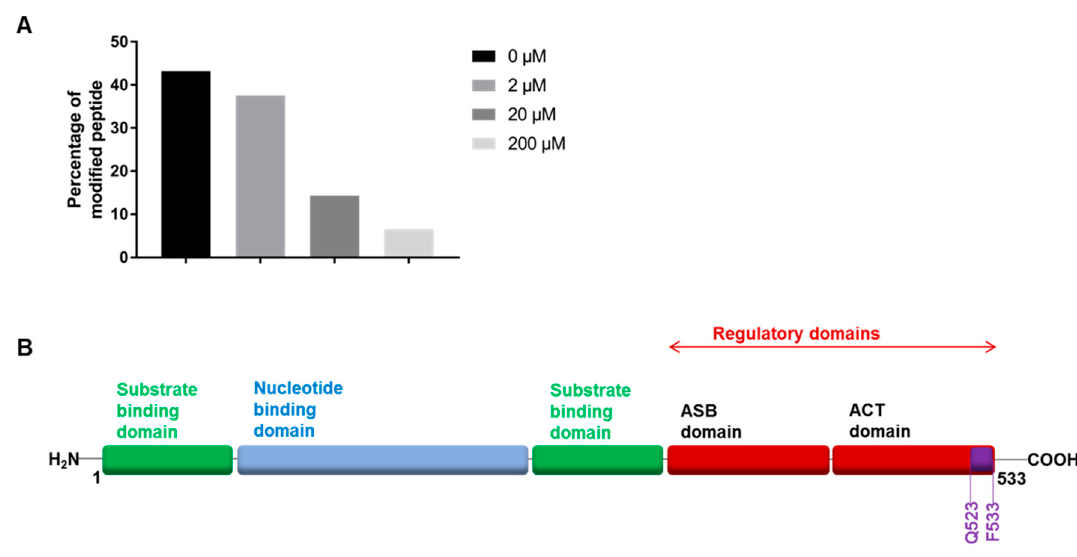
Figure 6. Result of the photoactivation experiment. ( A ) Percentage of the modified QHVTEAFQFHF peptide after incubation with compound 2 at different concentrations determined from the peptide spectrum matches (PSMs) of their precursors after trypsinization and analysis by nanoUHPLC/MS. Compound 2 was incubated with PHGDH in 50 mM Tris and 1 mM EDTA at pH 8.5 during 1 h before adding 1 mM of 11. ( B ) Schematic structure of full-length human PHGDH with substrate-binding domain in green, nucleotide-binding domain in blue, regulatory domains in red and diazirine modified peptide in purple. Adapted from Ravez et al. [10].